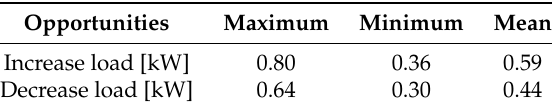
Figure 8. Energy usage profile in 15-min intervals of RBSA home 13019. The black line denotes the electric service for the whole-building. The vertical distance from the black line down to the green line is the instantaneous load that could be shed. The vertical distance from the black line up to the red line is the instantaneous load that could be added. The energy usage of 2 refrigerators and a freezer are depicted by purple, light blue, and dark blue dashed lines at the bottom of the graph. RBSA home 13019 is representative of homes with gas DHW heaters. Table 2. Load-shaping opportunities across 15-min intervals for Home 13019 for the first six hours during 1 April